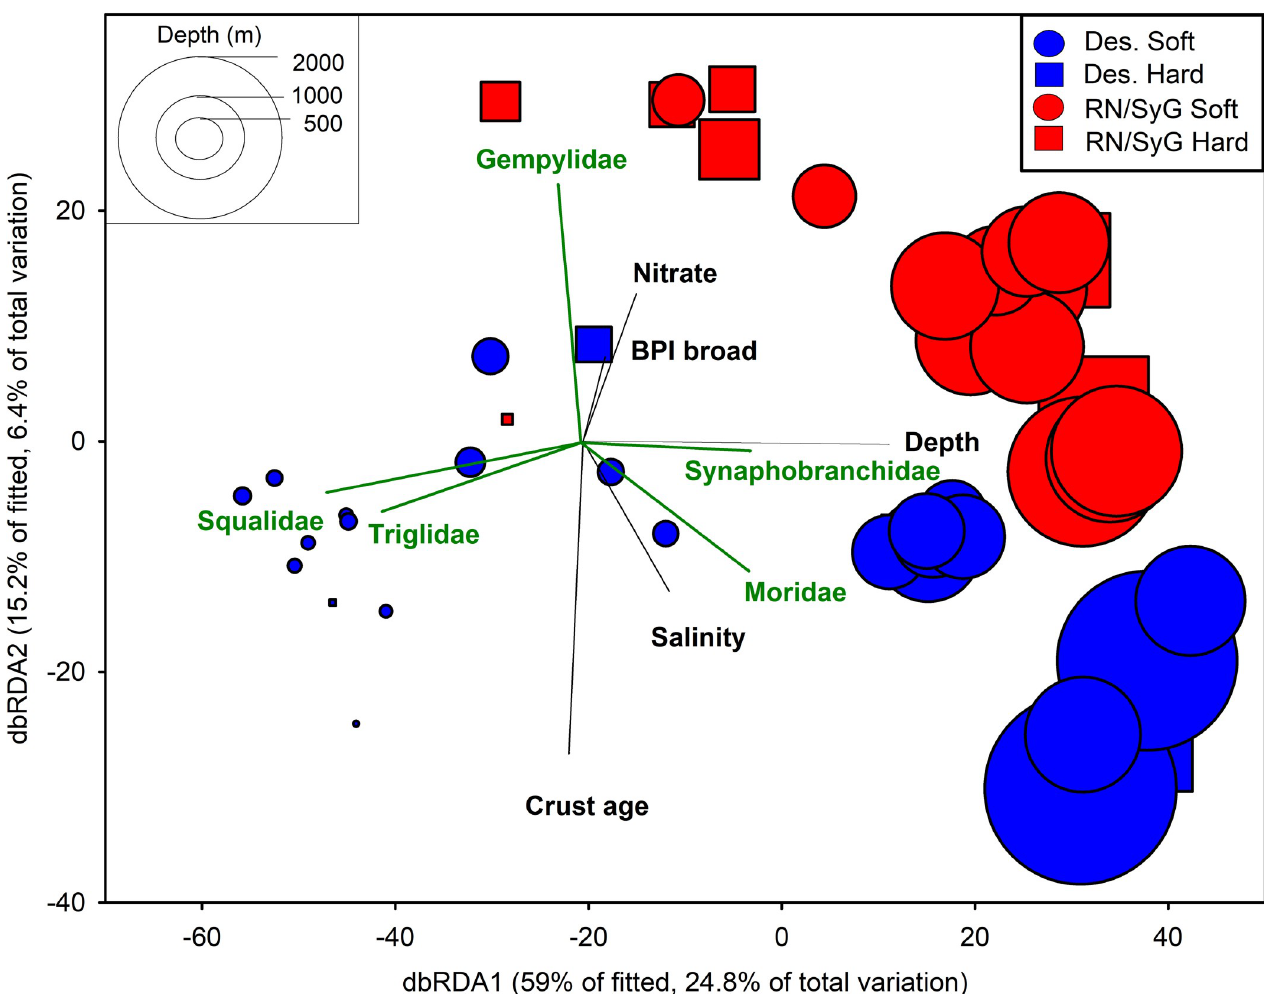
Fig 9. Distance-based redundancy analysis (dbRDA) ordination to investigate the relationship between the environmental variables and fish assemblages. Bray-Curtis similarity matrix based on 4 th root-transformed MaxN higher level fish taxa. Symbol sizes are proportional to depth.